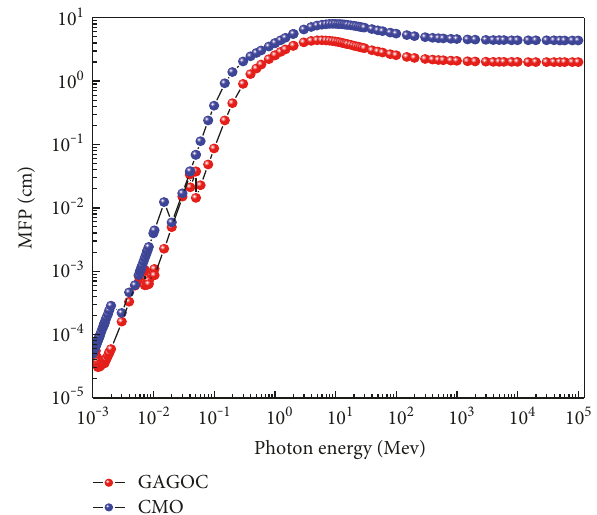
Figure 4: Variation of MFP versus incident photon energy for GAGOC and CMO.